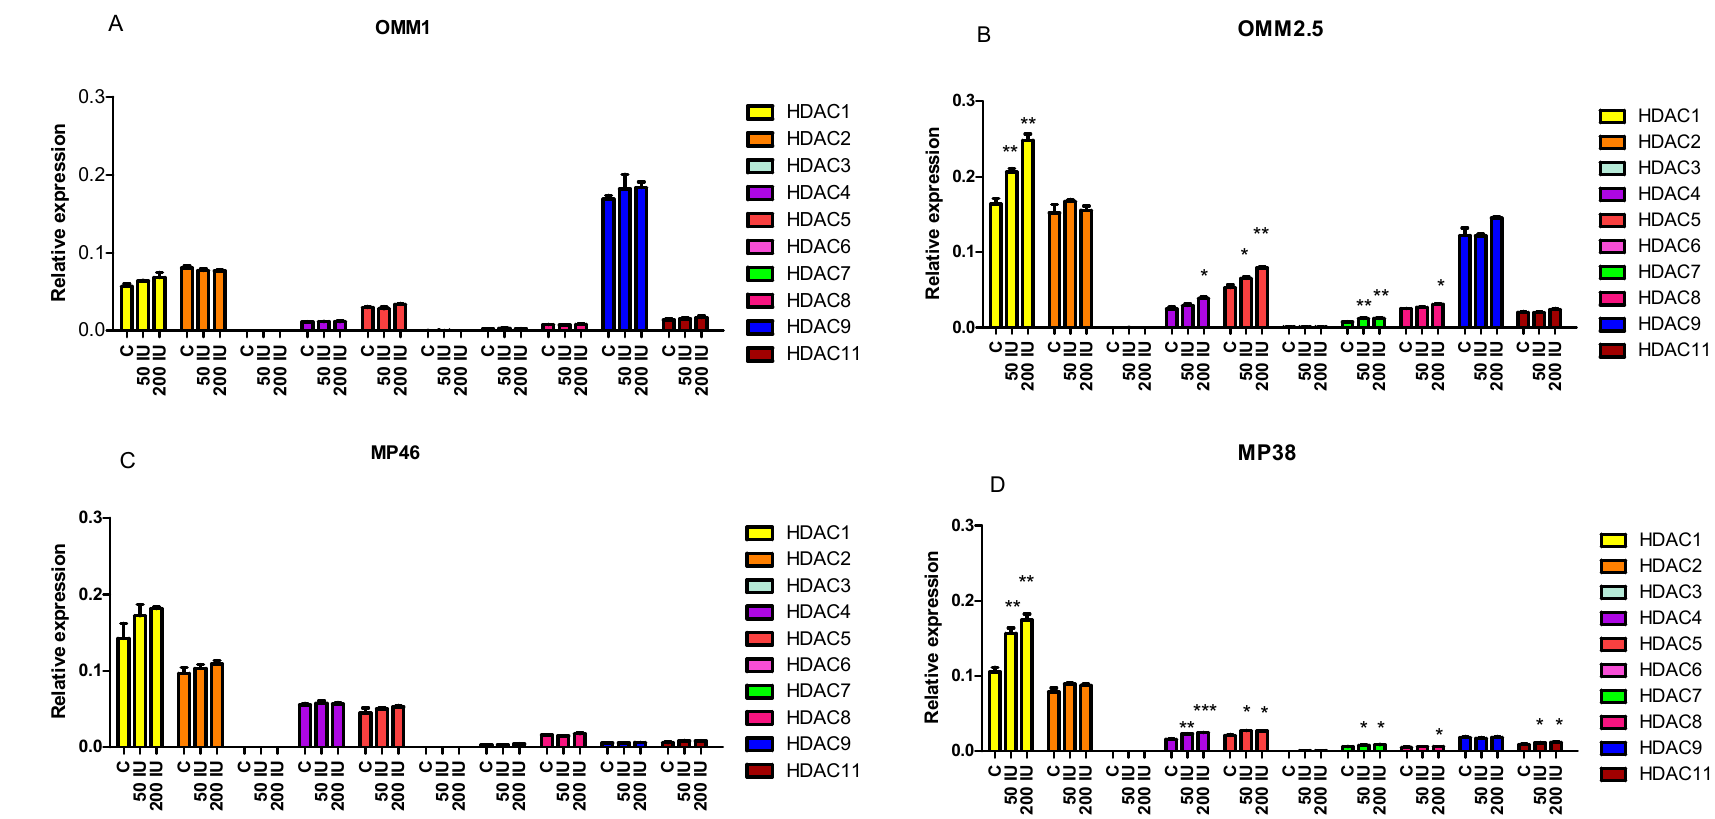
Figure 3. HDAC mRNA levels after 48 h of treatment with IFN ɤ compared to control. MRNA expression was determined by qPCR in four UM cell lines ( A–D ). C: control; 50IU: 50IU IFN γ ; 200IU: 200IU IFN γ . Using an Independent t -test, * p ≤ 0.05, ** p < 0.01, *** p < 0.001. Error bars indicate the standard error of the mean.